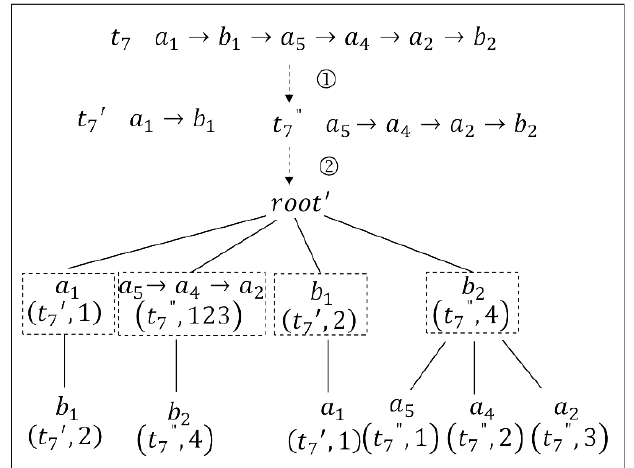
Figure 5. Updating of the TP-tree by using splitting. The number 1 (cid:13) represents t 7 is split from b 1 to obtain t 7 (cid:48) and t 7 (cid:48)(cid:48) , and 2 (cid:13) represents the construction of a new TP-tree* about the trajectory t 7 (cid:48) and t 7 (cid:48)(cid:48)